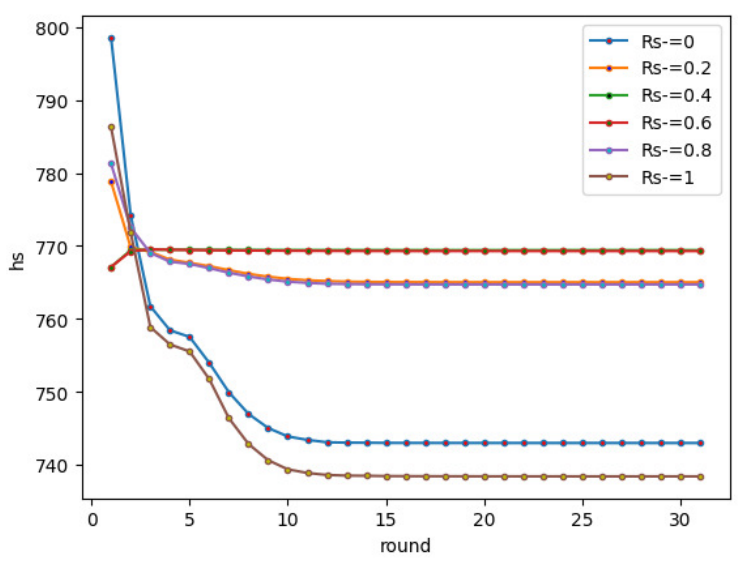
Figure 7. Effect of negative opinions on network.